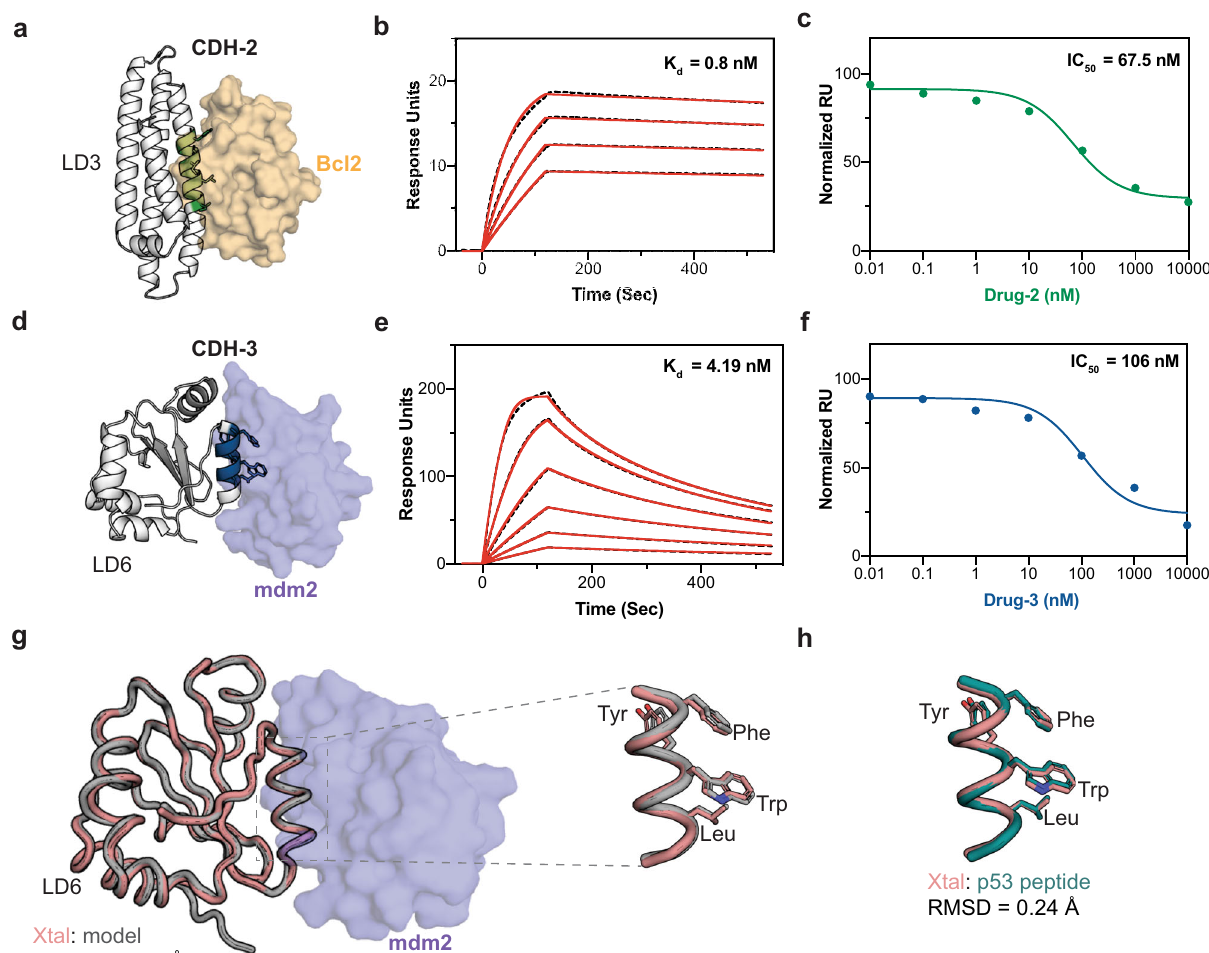
Fig. 2 Biochemical and structural characterization of novel CDHs. a Structural representation of CDH-2 composed of Bcl2 (beige surface) and LD3 (white cartoon) with the interfacial segment colored in green, the hotspot residues transplanted from the BH3 motif are shown in sticks. b SPR measurements of CDH-2 binding af fi nity. The dissociation constant determined for the interaction of Bcl2 with LD3 is 796 pM. c SPR drug competition assay determined the apparent IC 50 of CDH-2 with Drug-2 around 67.5 nM. d Structural representation of CDH-3 composed of the mdm2 (purple surface):LD6 (white cartoon) complex with the interfacial segment colored in blue, the hotspot residues transplanted from the p53 are motif shown in sticks. e SPR measurements of CDH-3 binding af fi nity. The dissociation constant determined for the interaction of mdm2 with LD6 is 4.19 nM. f SPR drug competition assay determined the apparent IC 50 of CDH-3 with Drug-3 around 106 nM. g The crystal structure of the CDH-3 consisting of the complex LD6 (pink tube) with mdm2 (purple surface) was in close agreement with the computational model of LD6 (gray tube) with complex with mdm2. h Transplanted hotspot residues in LD6 in sticks (pink) aligned with p53 peptide residues (teal) in a RMSD of 0.24